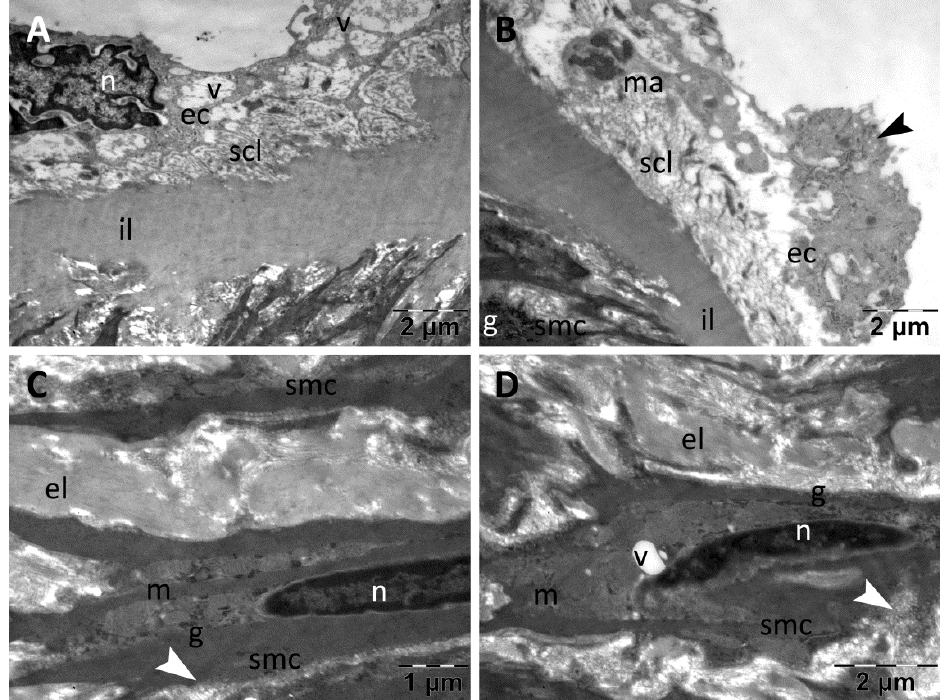
Figure 8. TEM investigation of the descending aorta in rats with HFD for 9 months; the last month with experimental-induced diabetes mellitus and with oral gavage CMC administration showed intima with vacuolated endothelial cells ( A , B ), some detached from the subendothelial connective layer into which macrophages were still present ( B ); media showed normal ultrastructural aspect ( C , D ), but some vacuoles were noted in the muscle cells ( D ) (arrowhead, vesicles of endocytosis in muscle cells and transcytosis in endothelial cells; ec, endothelial cell; el, elastic lamina; il, inner elastic lamina; g, glycogen; m, mitochondria; ma, macrophage; n, nucleus; scl, subendothelial connective layer; smc, smooth muscle cell; v, vacuole).